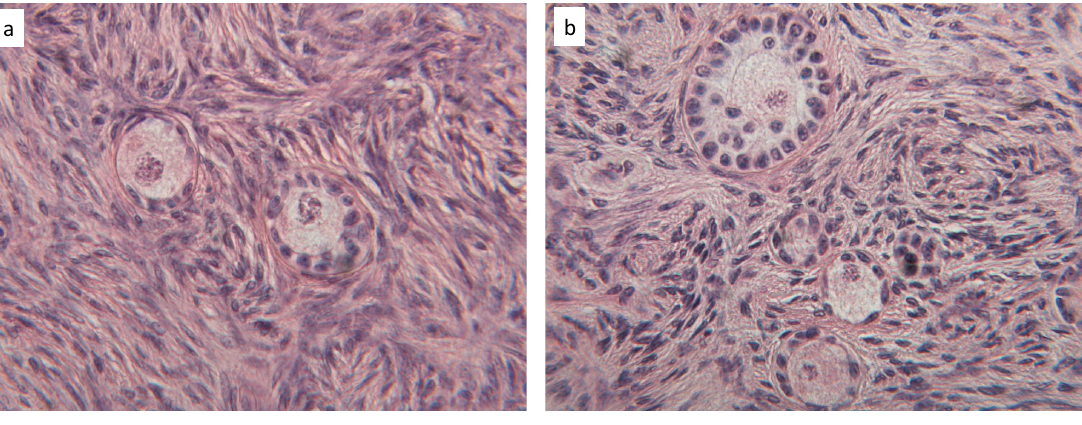
Figure 9. Exemplary histological sections of cortical ovarian tissue before ( a ) and after ( b ) mechanical testing.